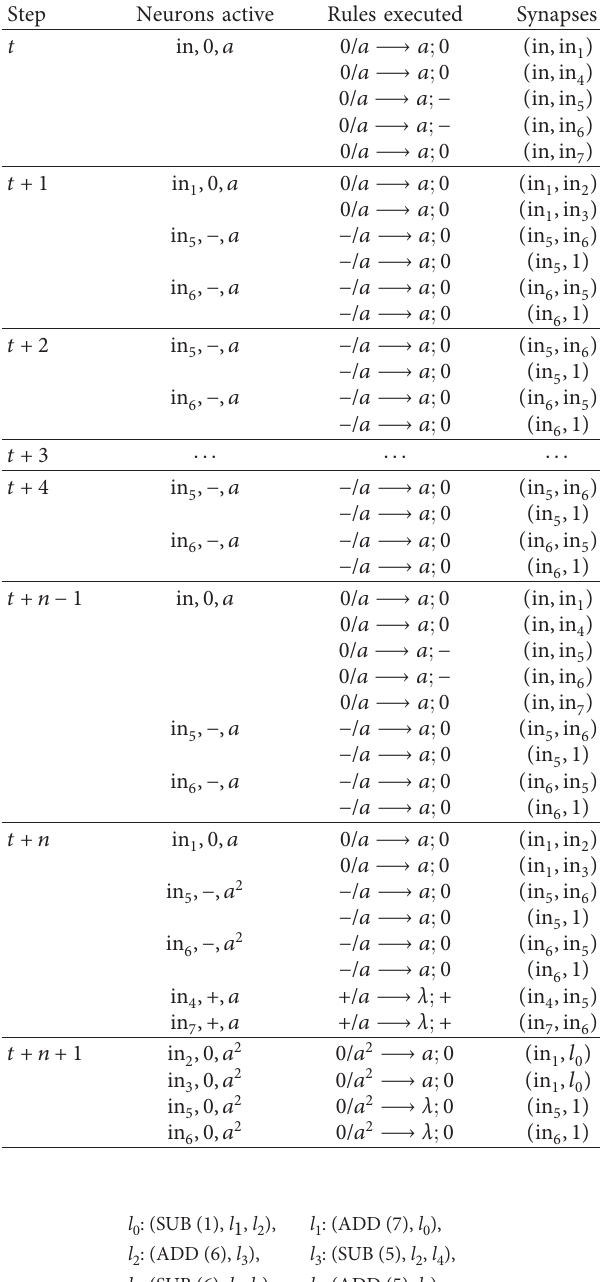
Table 1: Simulation for the INPUT module.